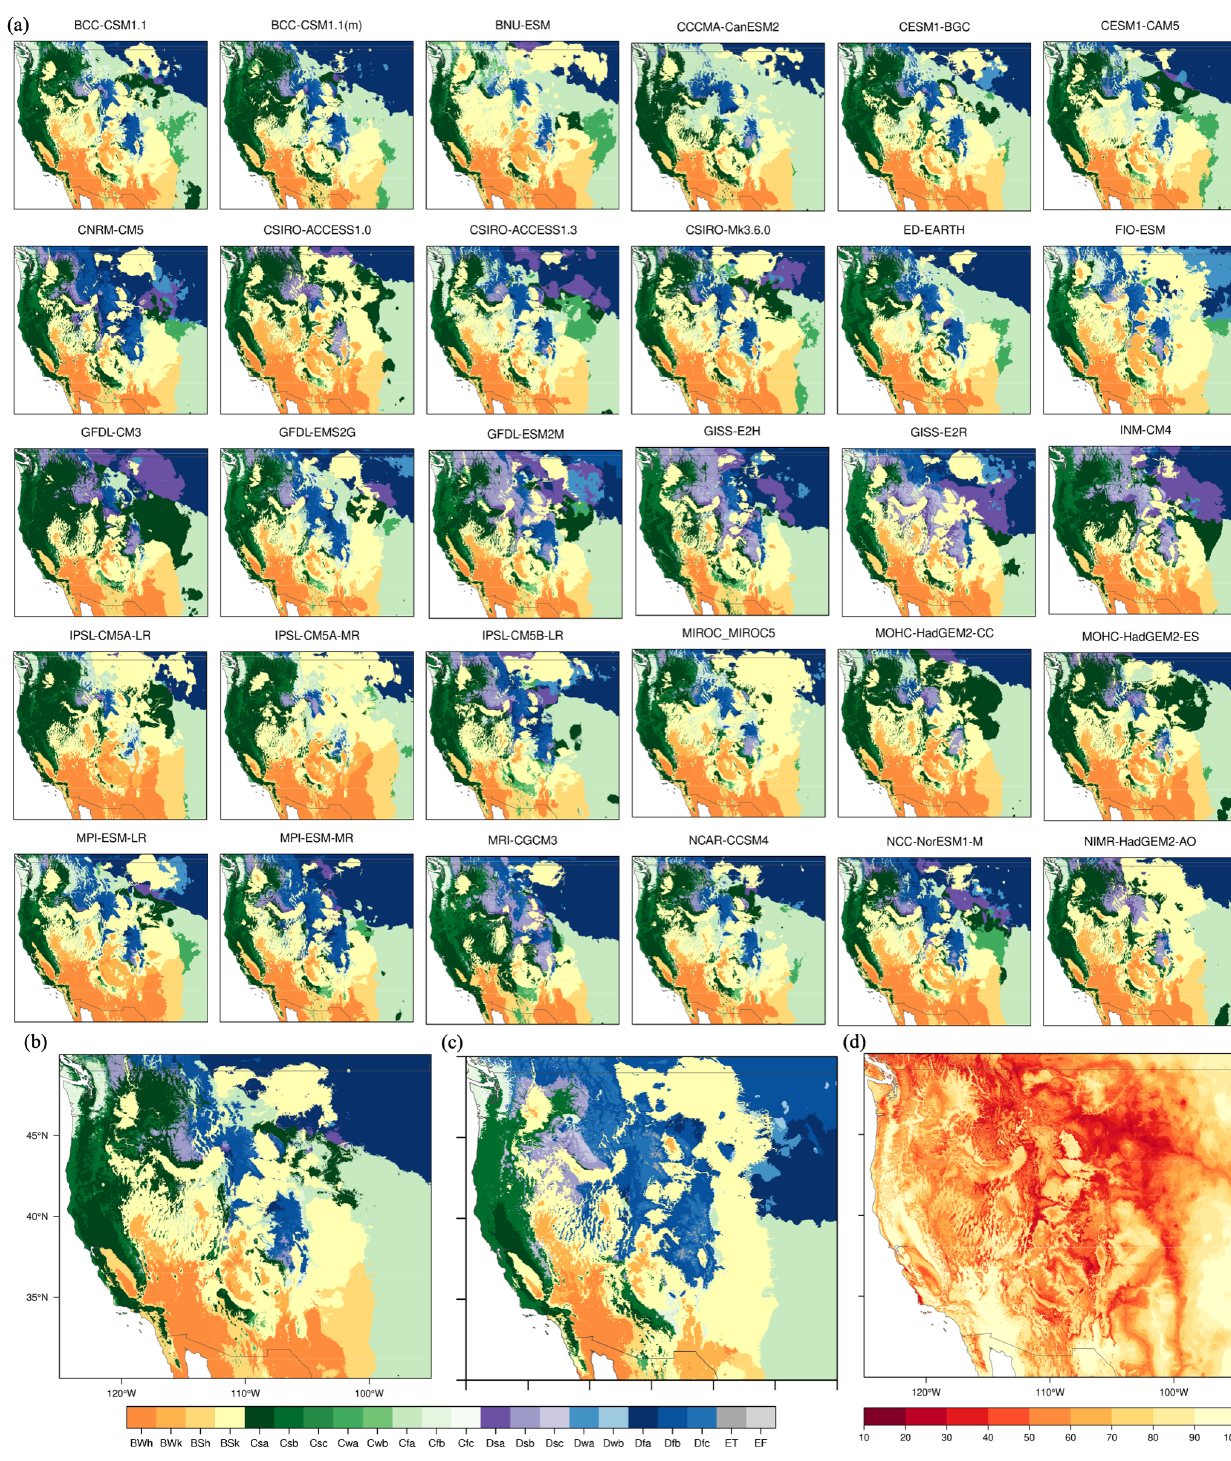
Figure 12. Future Köppen–Geiger classification and confidence map for 2060–2089 under RCP8.5 with resolution of 1km for the central Rocky Mountains in North America. (a) Climate maps based on 30 GCMs, (b) the final climate map derived from the most common climate class among all the 30 climate maps, (c) present climate map of 1979–2008, and (d) confidence level distribution of the final climate map.